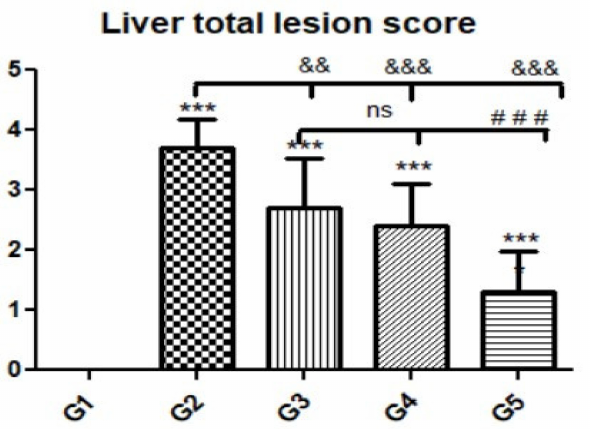
Figure 6. Quantitative and semiquantitative measurements of total lesion scores in liver tissue sections in the experimental groups. Data are expressed as the mean ± standard deviation. Significant differences (control group vs. other groups) are indicated by asterisks *, G2 vs. G3, G4, and G5 are marked by #, and G3 vs. G4 and G5 are marked by &. All tests were one-way ANOVA with Tukey’s